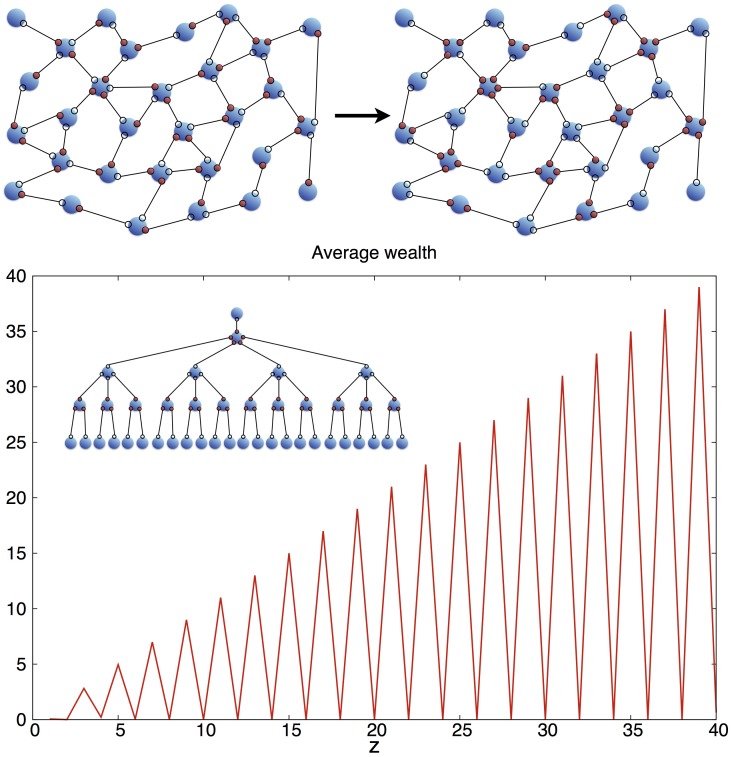
Top: same society as in Fig 1 but with hard constraints, which limit exchanges to pairwise action among agents and its optimized state. Bottom: The distribution of average wealth vs. opportunity optimizing power for a hierarchical fractal tree with l = 40 (The inset reports the case l = 5) as a (pathological) example of how hard constraints can severely frustrate wealth polarization.